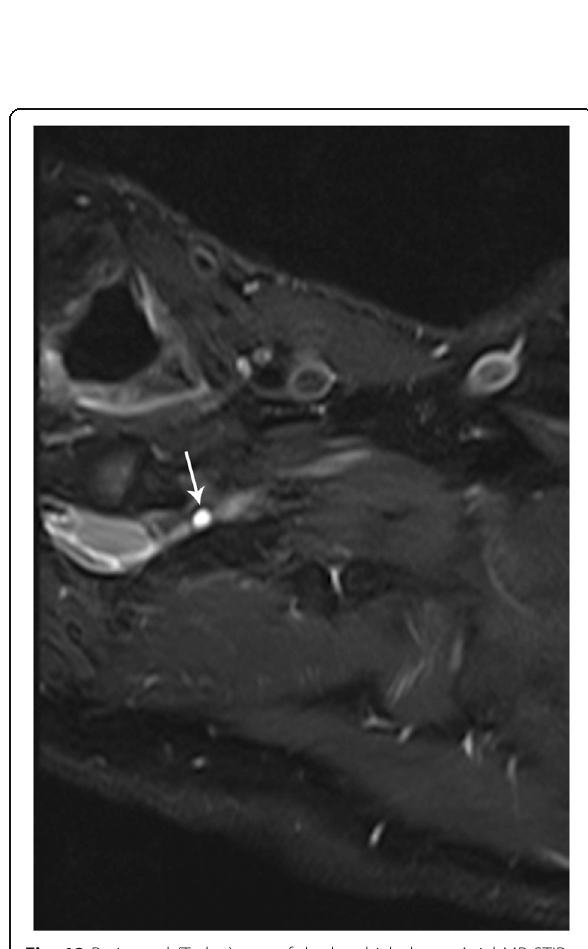
Fig. 12 Perineural (Tarlov) cyst of the brachial plexus. Axial MR STIR image demonstrates a cerebral spinal fluid intensity simple cystic structure (arrow) arising from the left C6 – 7 nerve root sheath consistent with a perineural (Tarlov) cyst